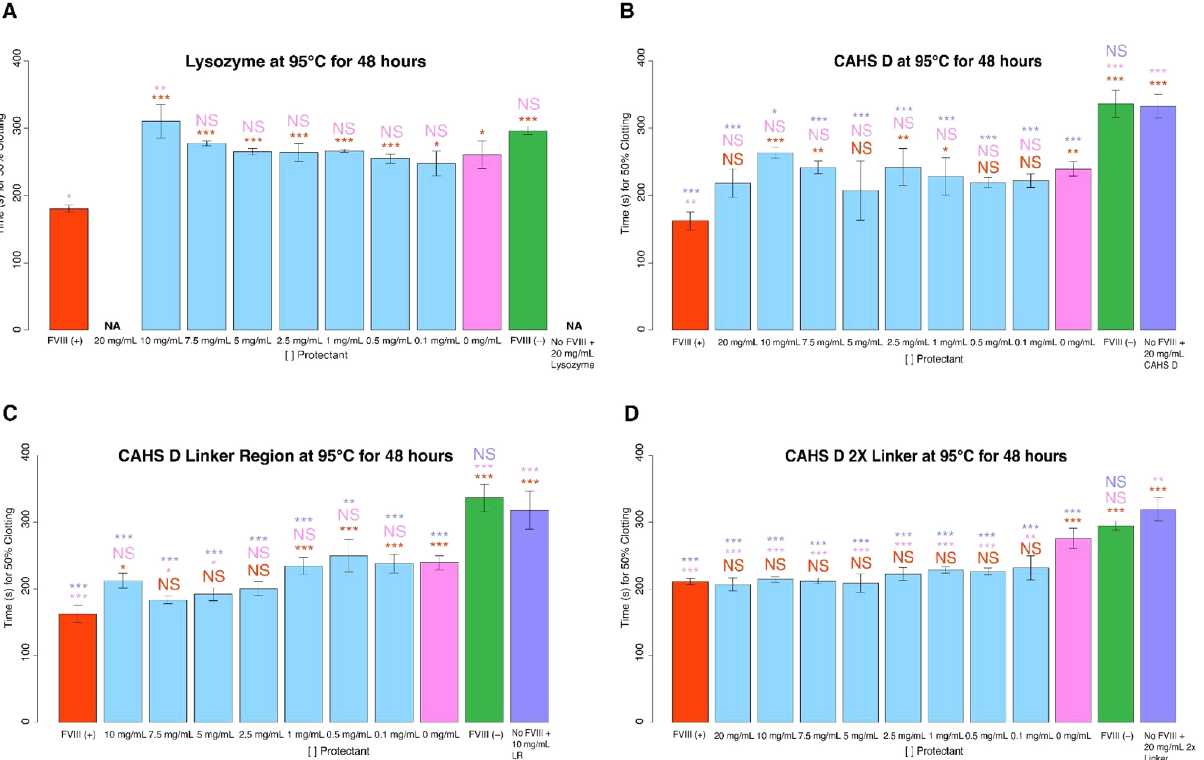
Figure 6. Using CAHS D and engineered CAHS D variants as potential stabilizers of FVIII under thermal stress. Histograms of 50% clotting time of FVIII treated with ( A ) lysozyme, ( B ) CAHS D, ( C ) CAHS D Linker Region, or ( D ) CAHS D 2X Linker prior to desiccation and thermal stress. The red “FVIII (+)” bar represents FVIII deficient human blood plasma treated with non-perturbed FVIII. All red notations above sample bars represent statistical comparison with “FVIII (+).” “X mg/mL’’ notation beneath sample bars correspond to the concentration of protein mixed with FVIII before desiccation. All pink notations above sample bars represent statistical comparison with “0 mg/mL.” The green “FVIII (−)” bar represents FVIII deficient human blood plasma not treated with FVIII. “No FVIII + X mg/mL protein” represents FVIII deficient human blood plasma treated with X mg/mL protein, but no FVIII. All purple notations above sample bars represent statistical comparison with “No FVIII + X mg/mL protein.” “NA” denotes that, although the relevant experiment was conducted, no clotting was observed during the entire duration of the clotting assay. Notations above sample bars represent statistical significance determined by one-way ANOVA and Tukey’s post- hoc test. Error bars represent bi-directional standard deviation. P value > 0.05 = NS, P < 0.05 = *, P < 0.01 = **, P < 0.001 =